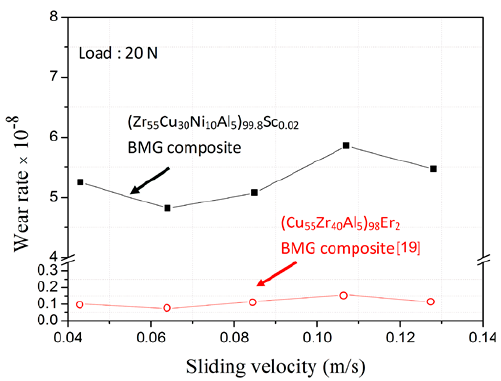
Figure 8. A plot of friction coefficient versus sliding velocity for the Sc-bearing Zr-based composite BMG.